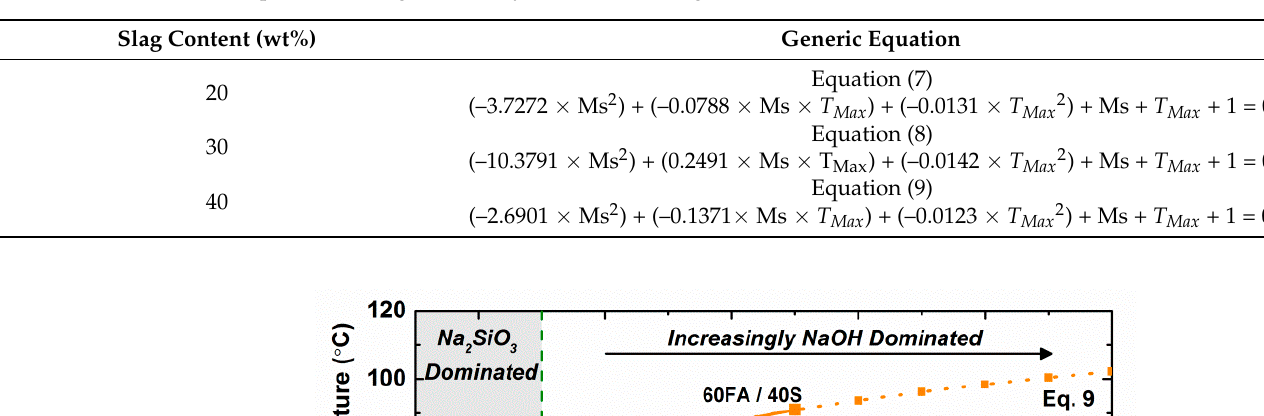
Table 5. Generic equations for prediction of maximal curing temperature for selected Ms values and maximal temperatures to achieve 45 MPa compressive strength in 28 days for different slag contents.